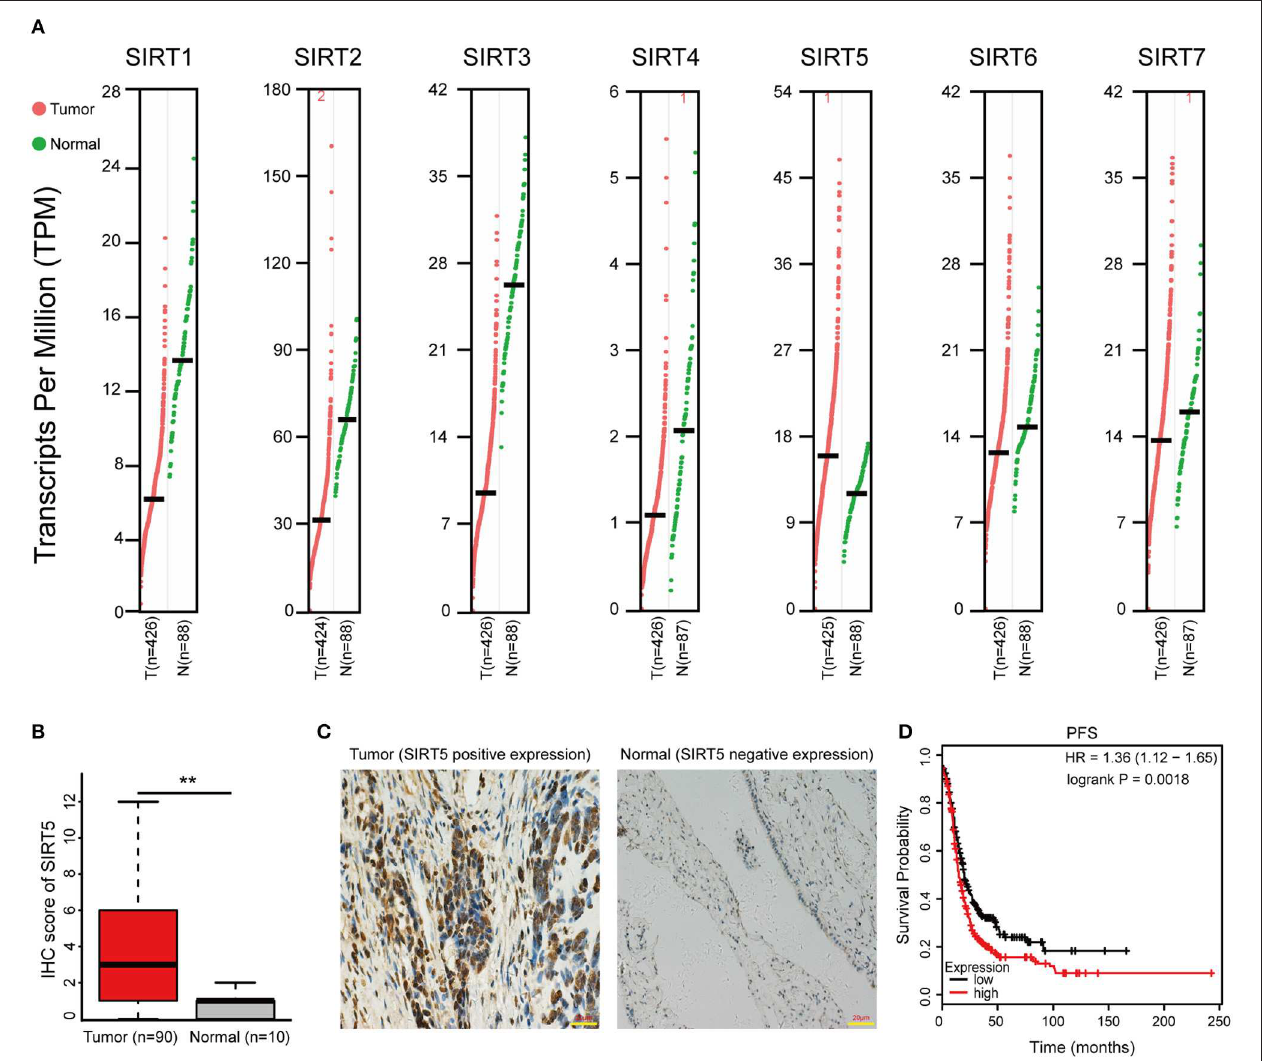
FIGURE 1 | SIRT5 expression is increased in ovarian cancer tissues and high SIRT5 level predicts poor chemo-response. (A) The mRNA expression of Sirtuins in patients with ovarian cancer (GEPIA). (B) Immunohistochemical staining results of SIRT5 expression in 90 cases ovarian cancer tissues and 10 cases normal tissues microarrays. (C) Representative immunohistochemical staining images of SIRT5 expression (positive or negative) in ovarian cancer and normal tissues. (Magnification, × 400; Scale bar = 20 µ m). (D) High SIRT5 level predicts poor progression-free survival (PFS) by online Kaplan-Meier analysis. ** P < 0.01.